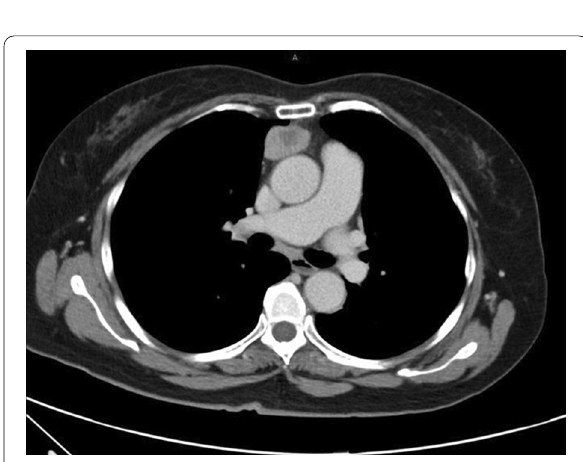
Fig. 1 Chest computed tomography scan revealing a 55 exophytic heterogeneously enhancing mass exhibiting some areas of necrosis